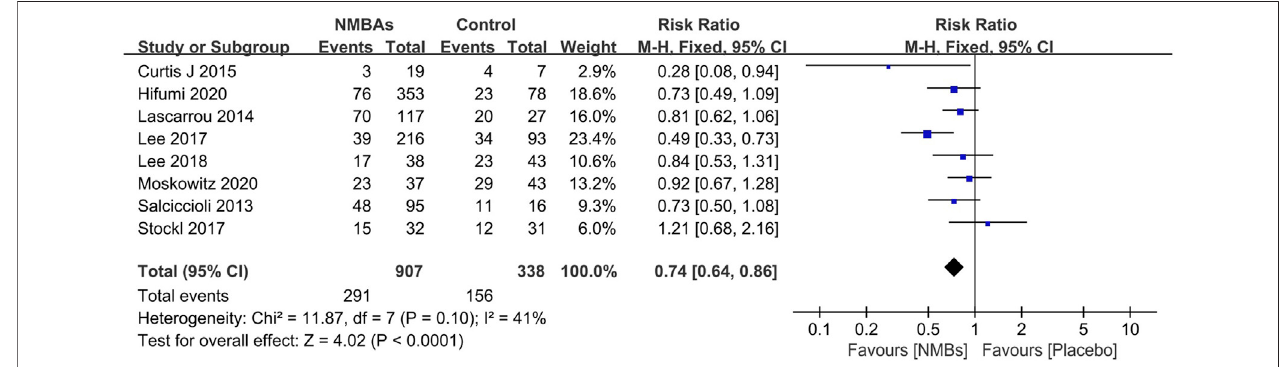
FIGURE 4 | Forest plot of comparing continuous neuromuscular-blocking agent to bolus neuromuscular-blocking agent regimen in outcomes of mortality (A) and poor neurological outcome (B)